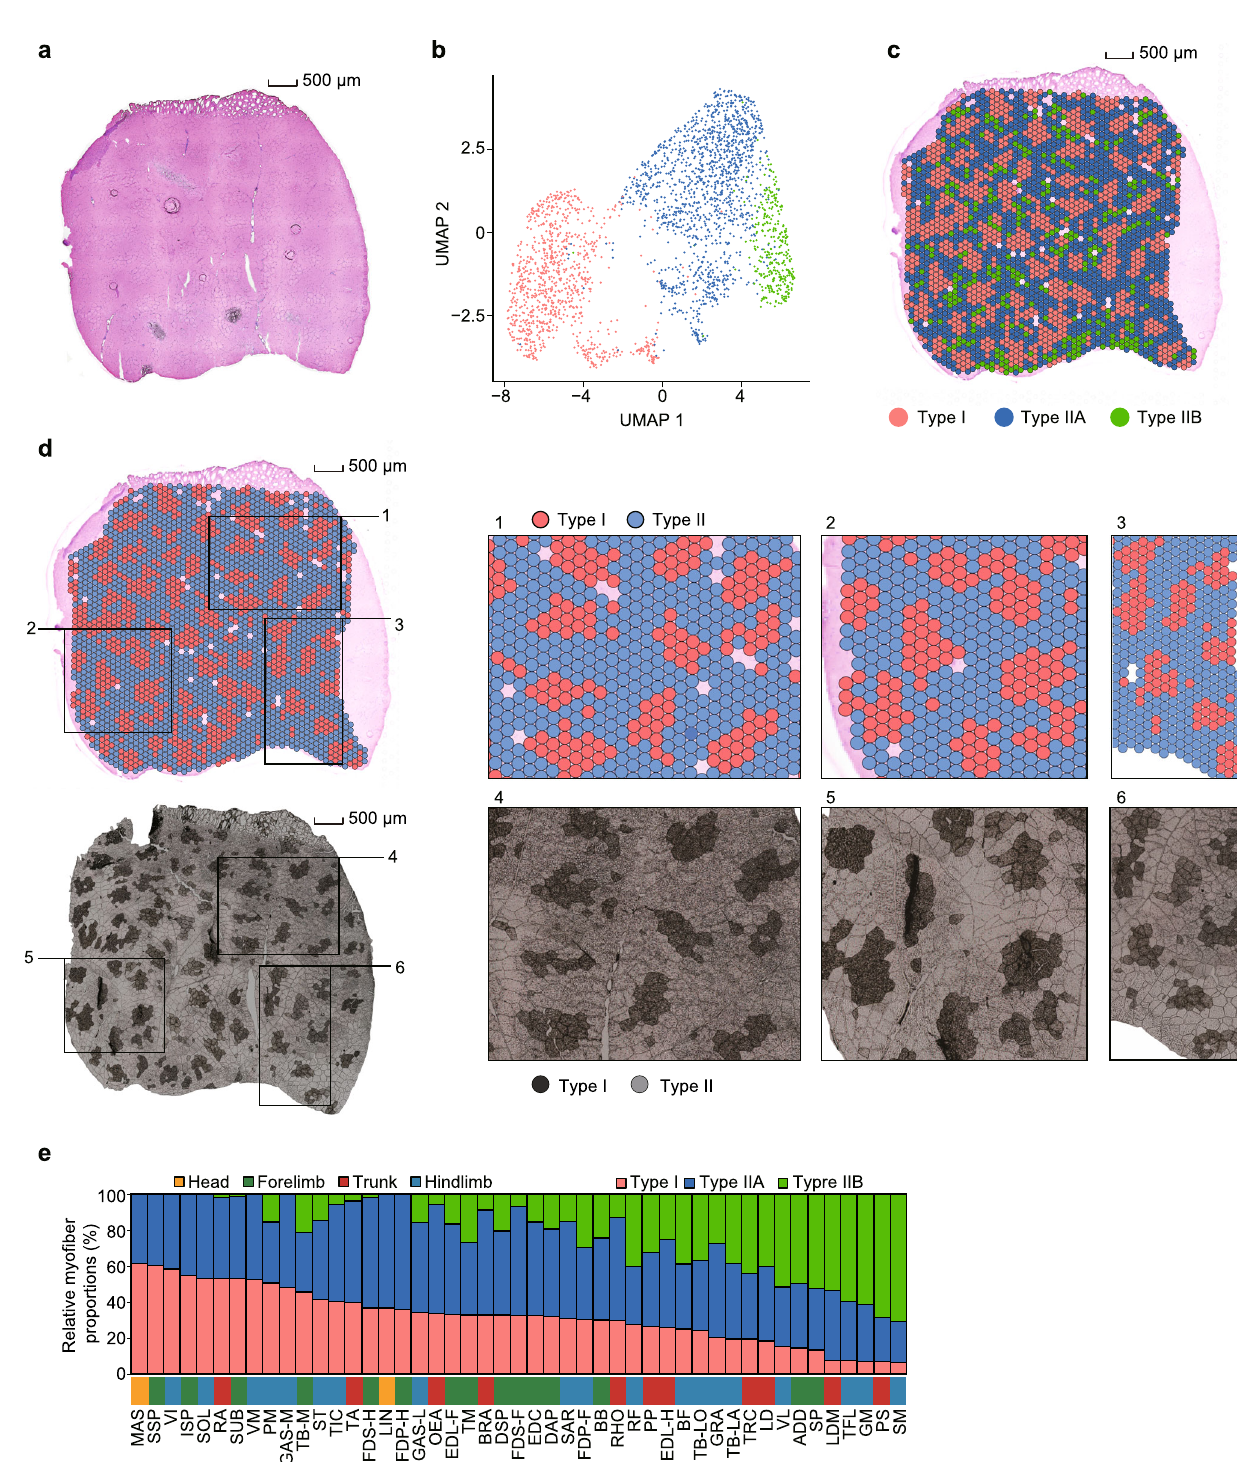
Fig. 4 Spatial transcriptomics (ST) illustrate the myo fi ber composition of SMTs. a Hematoxylin-and-eosin staining of psoas major (PM) muscle sections. Scale bars, 500 μ m. A representative image of two independent experiments is shown. b Dimensionality reduction and clustering of 2607 spots (replicate 2) identi fi ed as type I, IIA, and IIB myo fi ber clusters. The identi fi ed putative myo fi ber/spot clusters are annotated based on MYH transcriptional pro fi les, as well as marker gene transcription, shown in detail in Supplementary Figs. 21 and 22. c Mapping of data points from three putative myo fi ber clusters to their spatial positions. d Comparison of the location of type I myo fi bers identi fi ed in ST (upper panel) and ATPase-stained histological sections (lower panel) for replicate 2 (tissue sections adjacent to that in a ). In the ST plot (upper panel), type IIA and IIB myo fi bers were combined (shown in light blue). Scale bars, 500 μ m. Insets show three typical regions/images (denoted with numbers) magni fi ed for comparison matching results (1 vs. 4, 2 vs. 5, and 3 vs. 6). e Estimates of the myo fi ber proportions in bulk RNA-seq data using the expression signature matrix (442 and 450 genes for replicate 1 and replicate 2, respectively) of the three myo fi bers, shown as the average of replicate 1 and replicate 2. SMTs are ranked by their proportions of type I myo fi ber from high (left) to low (right). Source data are provided as a Source Data fi